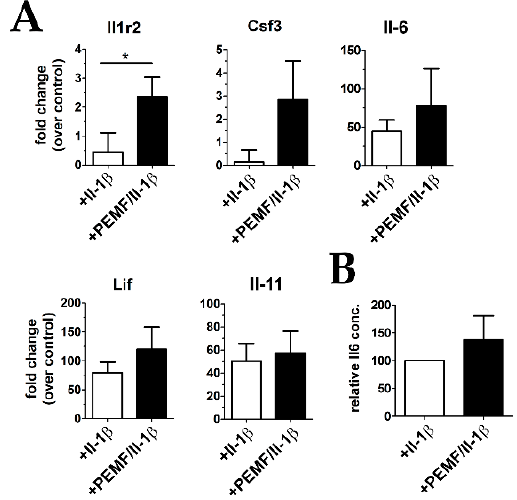
Figure 8. mRNA expression of cytoprotective cytokines. ( A ) Gene expression of Il1r2 was significantly up-regulated after PEMF treatment, and some members of potentially cytoprotective cytokines of the Il-6 / gp130 family also show an increase by trend ( n = 9) ( B ) Il-6 cytokine levels were also elevated in culture supernatants PEMF-treated constructs as evidenced by ELISA analysis ( n = 5). (Lif leukemia inhibitory factor, Csf3 colony-stimulating factor 3). * p < 0.05.